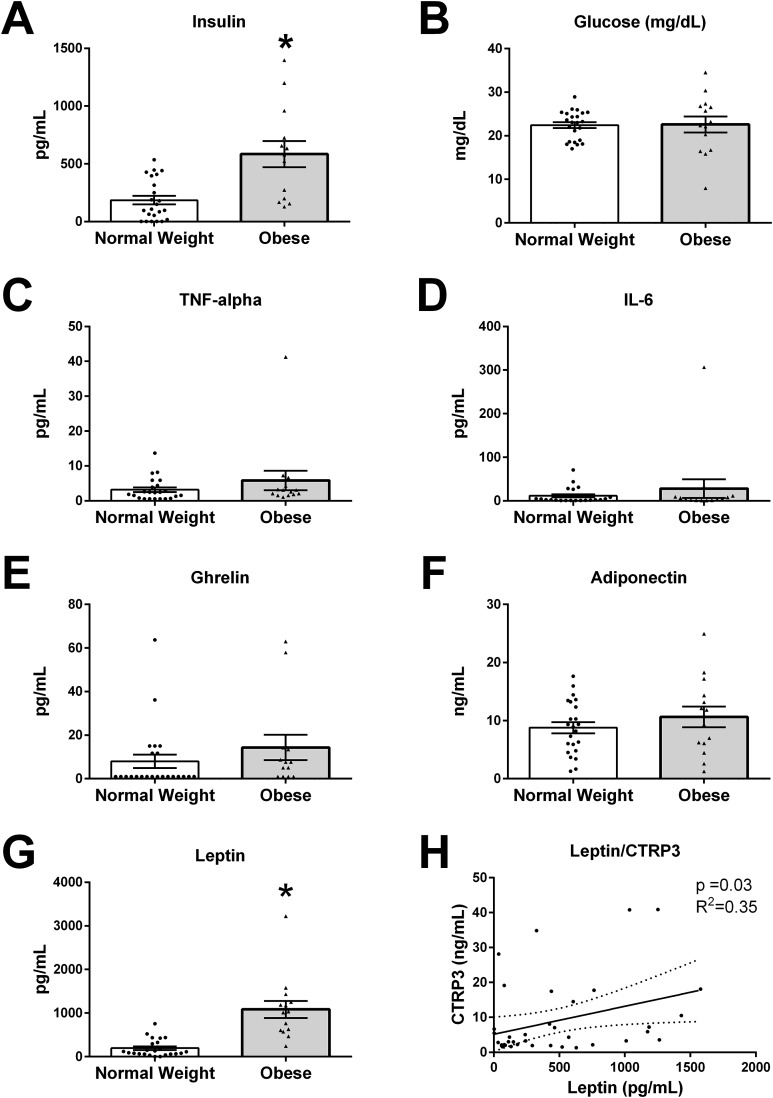
Humoral factors in breast milk (BM).The BM samples from 23 pregravid normal weight (BMI 18–25 kg/m2) and 14 obese (BMI > 30 kg/m2) mothers between 2 and 14 weeks of lactation were measured for (A) insulin, (B) glucose, (C) TNF-α, (D), IL-6, (E) ghrelin, (F) adiponectin, and (G) leptin (*p < 0.05 vs. normal weight group). Values are mean ± SEM, and dots, and triangles represent individual data points from each participant. (H) Associations between BM and CTRP3 and leptin protein concentration. Solid line (p = 0.03, R2 = 0.35, n = 37).